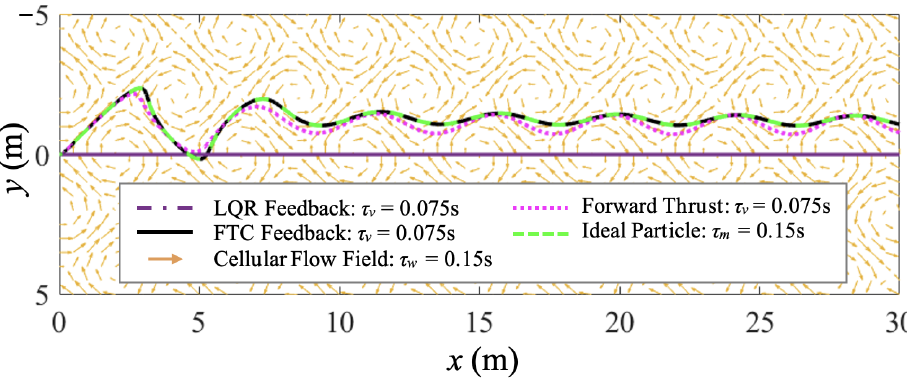
Figure 6. Case study 2: the trajectory comparison of the ideal fast-tracking particle with τ m = 0.15 s, and purely thrust-driven, FTC-controlled, and LQR-controlled vehicles with τ v = 0.075 s traversing a cellular flow with τ w = 0.15